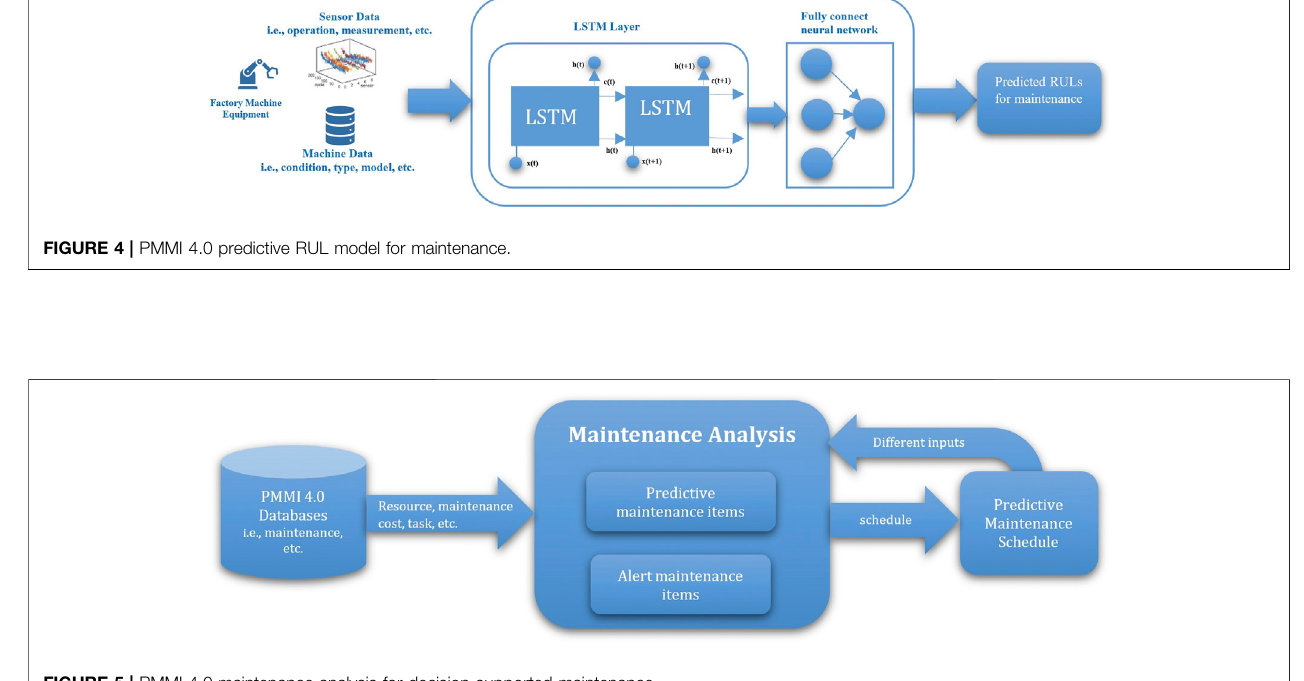
Frontiers in Big Data |